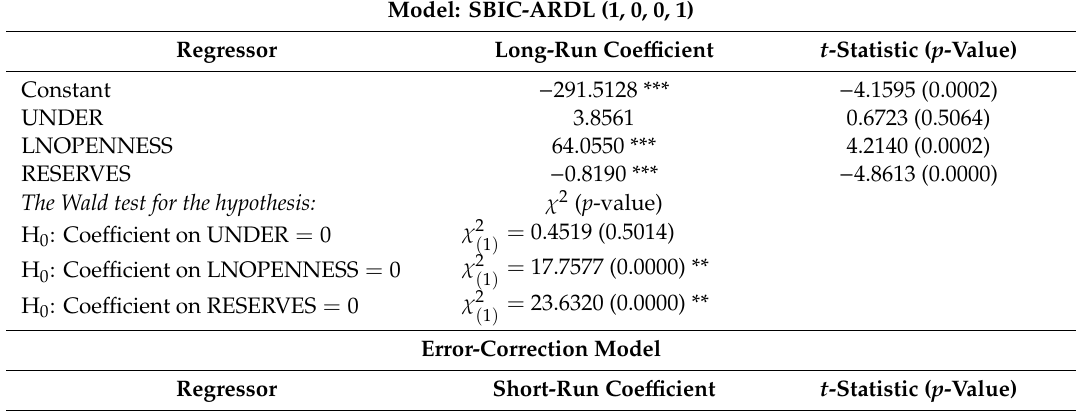
Table 7. Estimated coe ffi cients of the undervaluation dummy (UNDER) and other determinants of KF. Model: SBIC-ARDL (1, 0, 0,